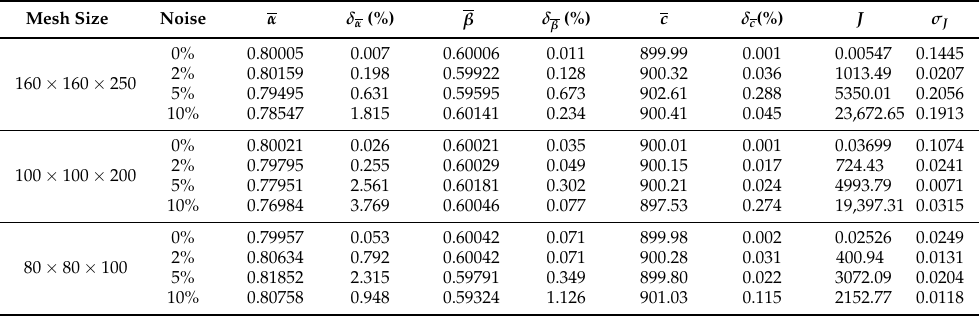
Table 4. Results of calculations in the case of seven measurements points K i ( i = 1,2, . . . ,7): α i — reconstructed value of x -directional order derivative α , β —reconstructed value of y -directional order i derivative β , c —reconstructed value of parameter c , δ —relative error of reconstruction, J —value of the objective function, σ —standard deviation of the objective function.